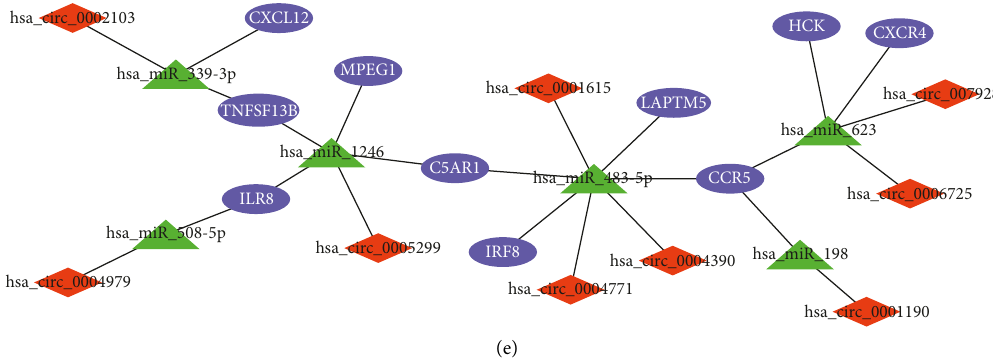
Figure 6: Constructing and analyzing the ceRNA network. (a) CeRNA network of circRNA-miRNA-mRNA interactions in atrial fi- brillation. (b) An analysis of the GO enrichment of mRNAs in the ceRNA network. (c) An analysis of the KEGG pathway enrichment of mRNAs in the ceRNA network. (d) PPI network construction and hub gene selection. (e) CircRNA-miRNA-hub gene subnetwork construction. Upregulated circRNAs are indicated by red diamonds, downregulated miRNAs by green triangles, and upregulated mRNAs by blue